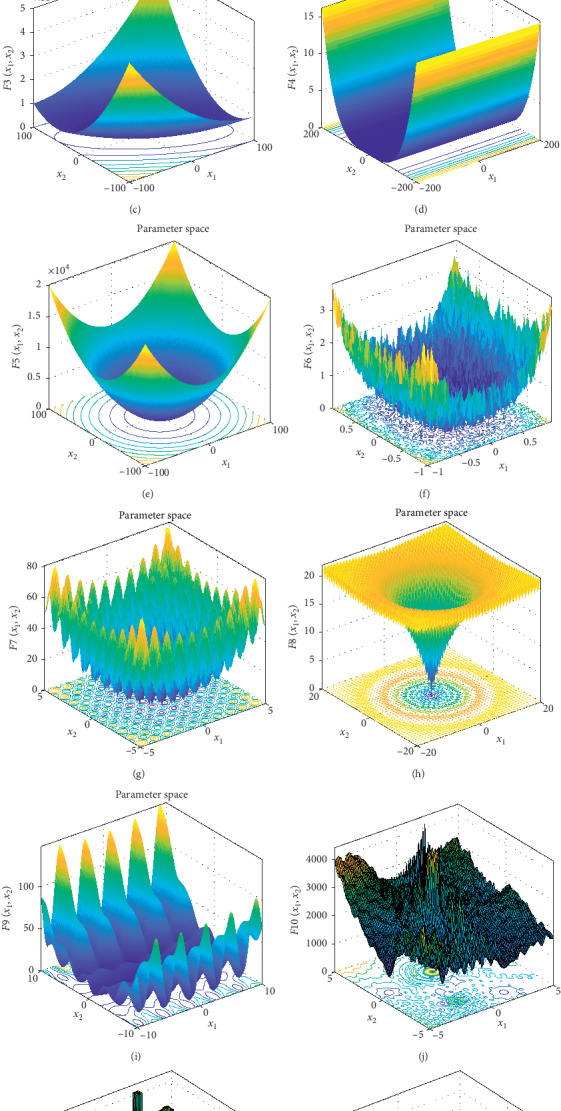
3D graphs of benchmark functions. (a) F1. (b) F2. (c) F3. (d) F4. (e) F5. (f) F6. (g) F7. (h) F8. (i) F9. (j) F10. (k) F11. (l) F12.